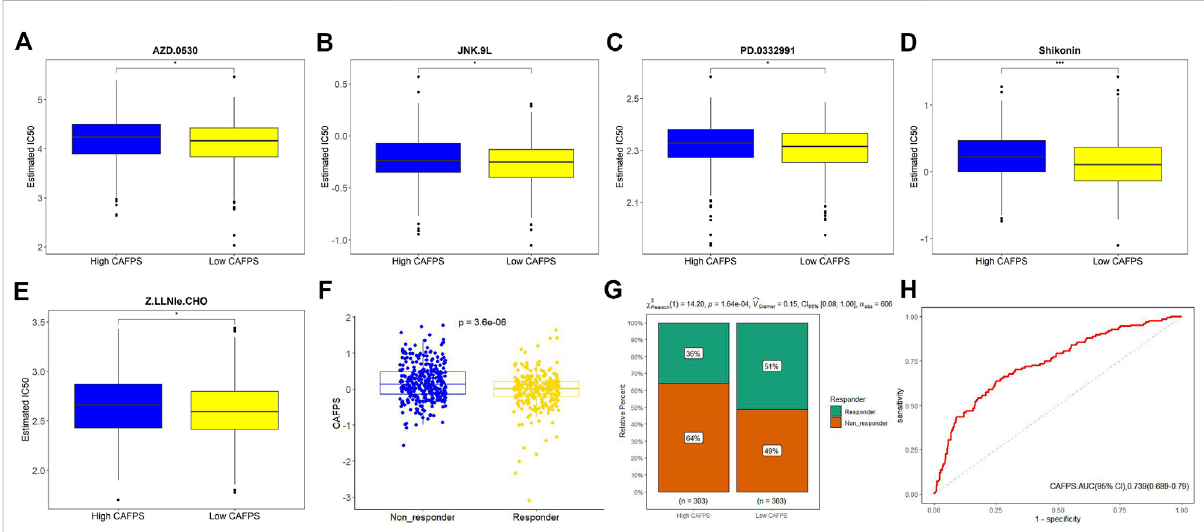
FIGURE 10 Drug sensitivity prediction in CRC patients. (A – E) Boxplot showing the mean differences in the estimated IC50 values of fi ve drugs (AZD.0530, JNK.9L, PD.0332991, shikonin, and Z.LLNle.CHO). (F) Distribution of TIDE value after prediction. (G) Responders to immunotherapy in the low and high CAFPS groups. (H) ROC curve of CAFPS for 1-year overall